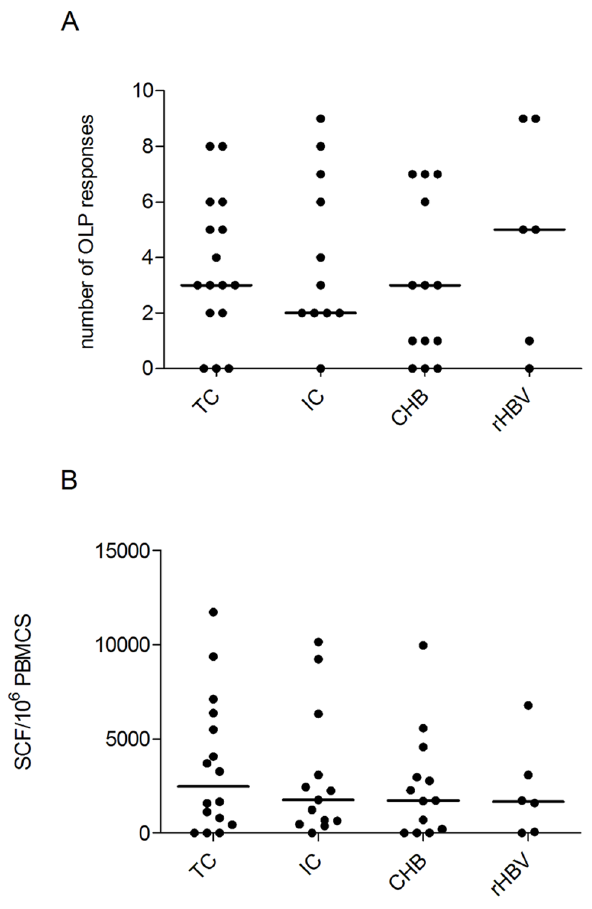
Figure 1. Breadth and magnitude of anti-HBV specific T cell response in the four groups of patients. A) Breadth (number of targeted peptides) and B) magnitude (number specific cells) of the anti- HBV specific T cell response in the four patients groups. Total magnitude was determined by adding magnitudes obtained for all targeted peptides by each patient. Each symbol represents an individual patient, with black horizontal bars showing the median values per patient